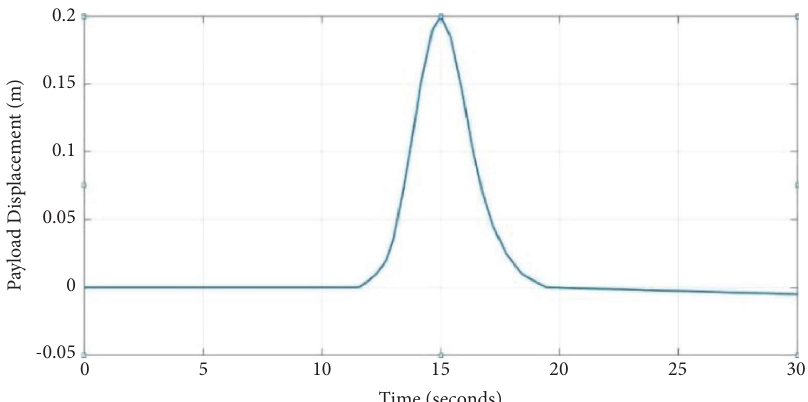
Figure 7: Te second input signal applied on the